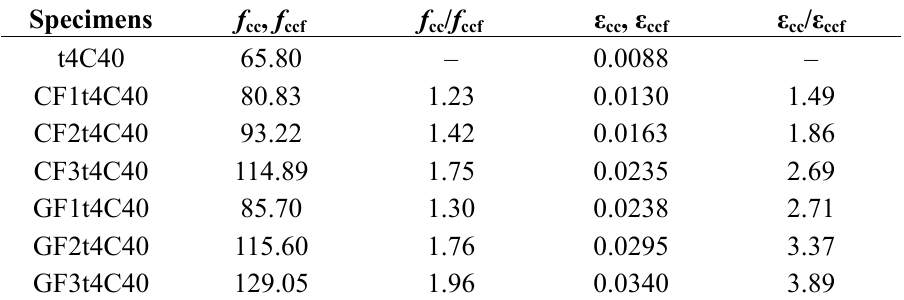
Table 3. Stress and strain of the confined concrete at the ultimate